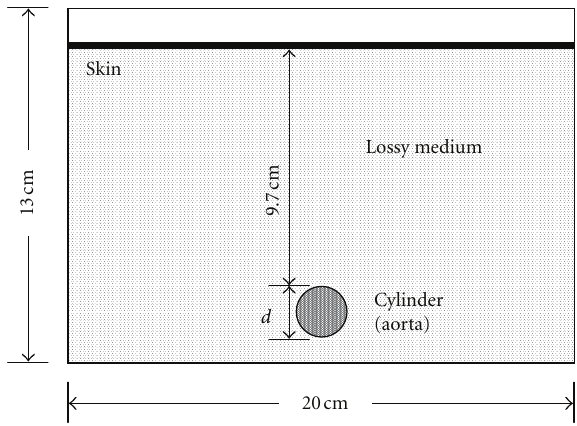
Figure 5: 2D simulation model for aorta’s diameter estimation. radar [54, 55]. Several other possible medical applications of UWB radar include ambulatory cardiac output monitoring, blood vessel movement recording, blood pressure celerity measurement, and shock diagnosis in emergency